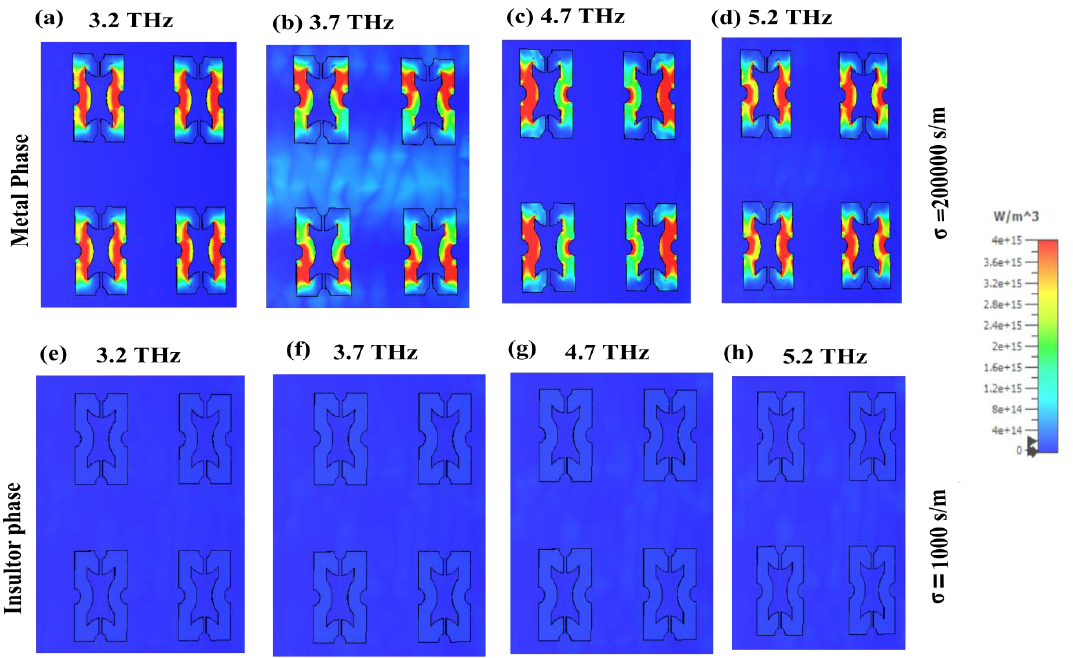
Figure 11. Simulated power loss density (PLD) at four ( f1, f2, f3, f4 ) absorption peaks in the VO 2 layer ( a – d ) when conductivity is 2 × 10 5 s/m and when ( e – h ) VO 2 is in its insulator phase at conductivity of 1 × 10 3 s/m.